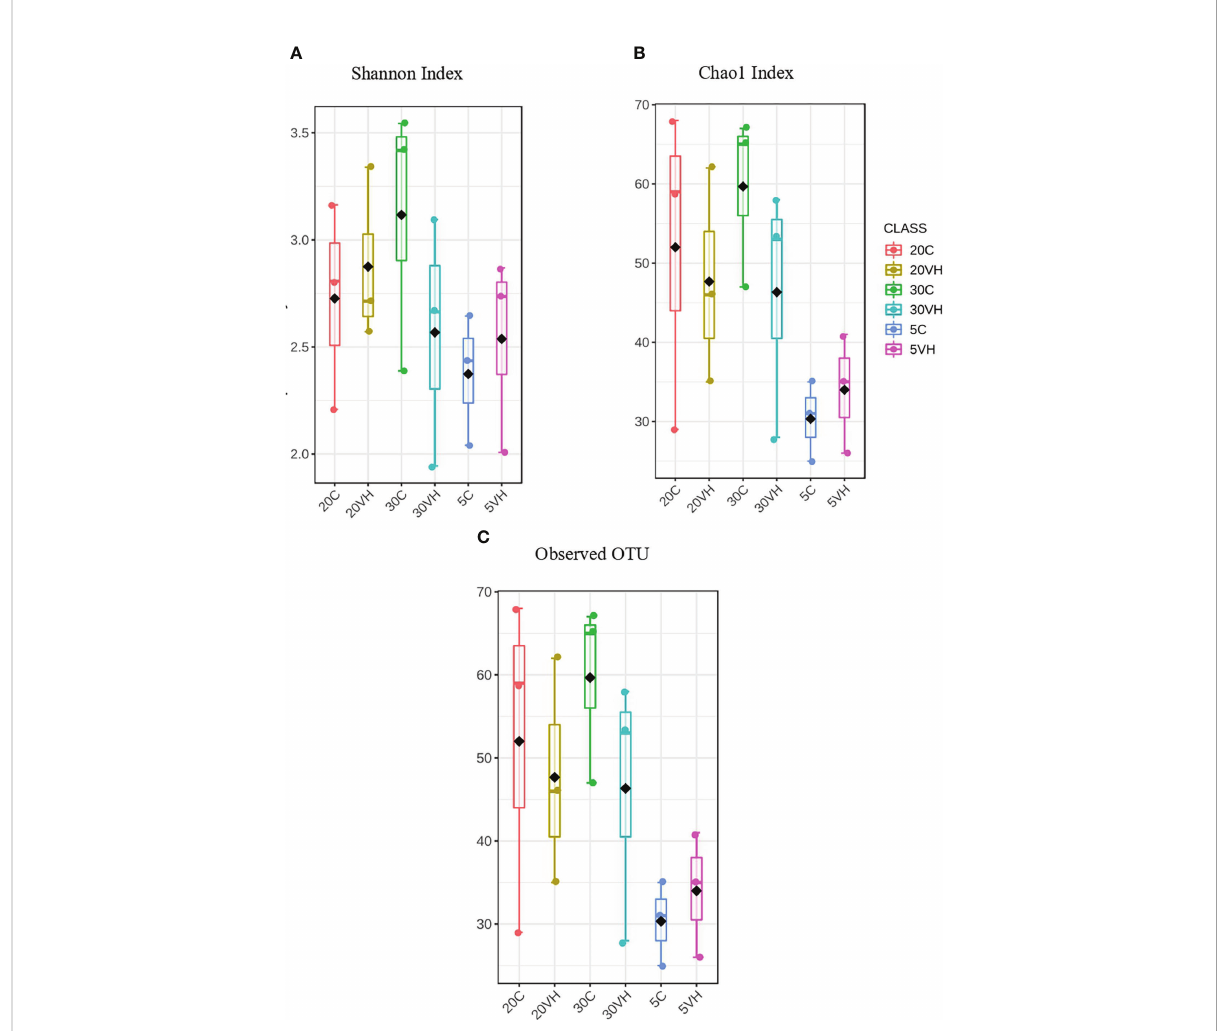
FIGURE 1 The a -diversity analysis of each group treatments of Litopenaues vannamei cultured at different salinity level and challenged with Vibrio harveyi (VH, Vibrio harveyi infected group and C, Control group; 5, 5 ppt; 20, 20 ppt and 30, 30 ppt). (A) Shannon index box plot and (B) Chao 1 index box plot and (B) Observed OTUs box